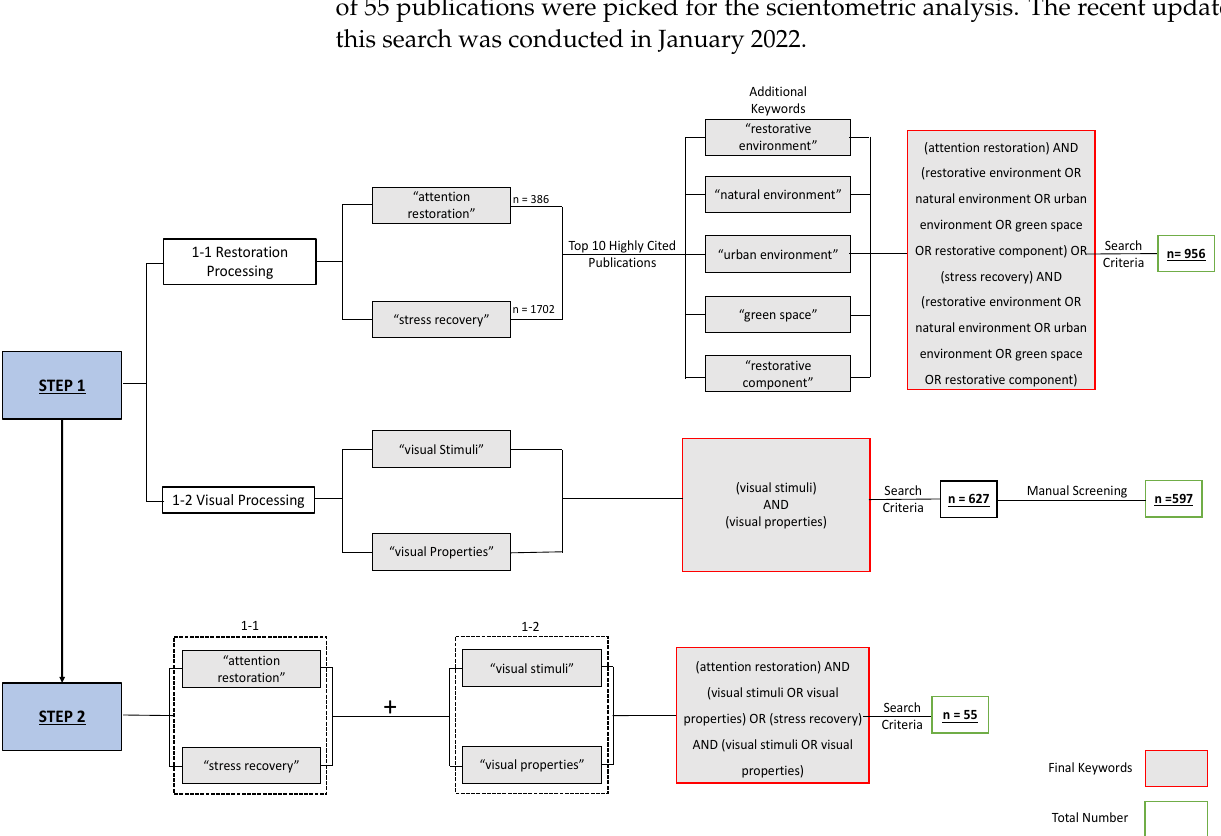
Figure 3. Keywords and the total number of publications for scientometric analysis of each step of the